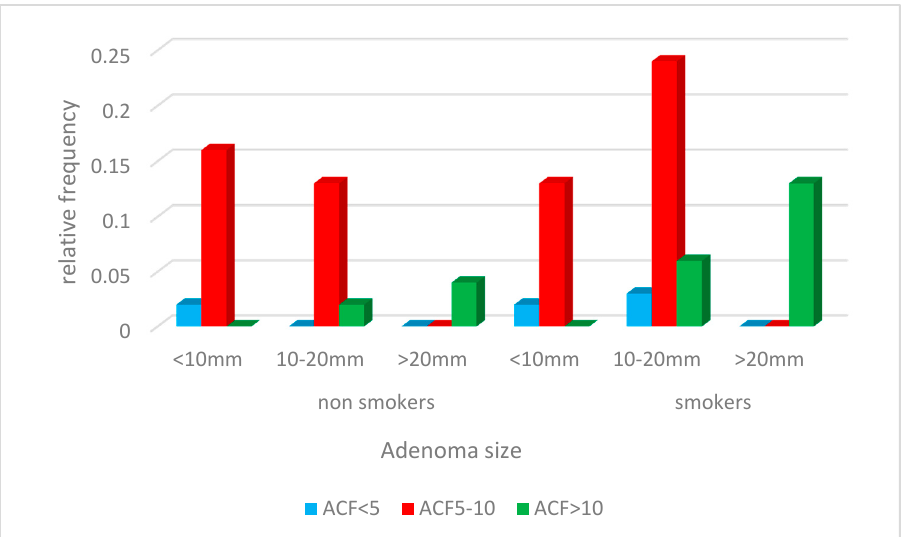
Figure 6. Adenoma size depending on the rectal ACF number in the smokers group.